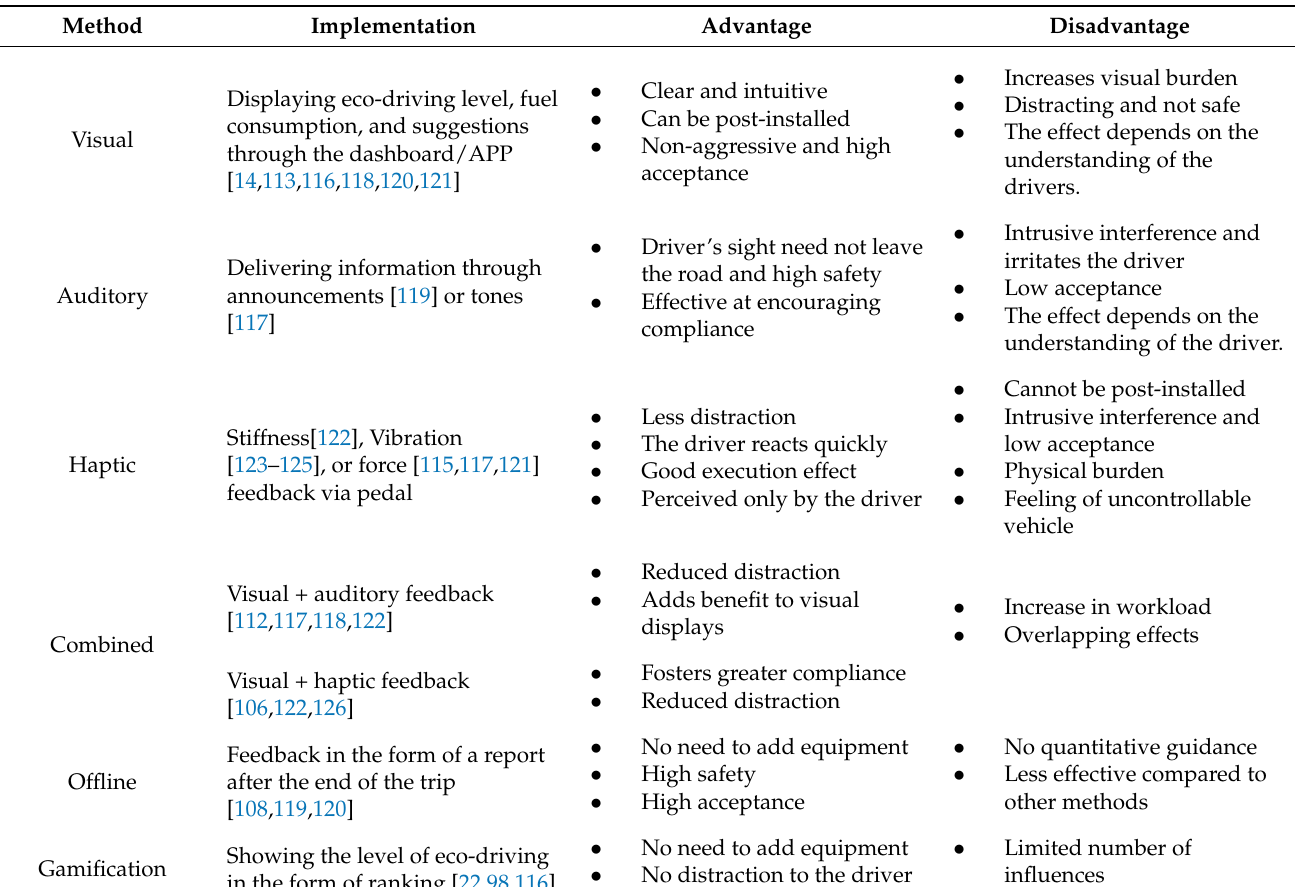
Table 3. The comparison of the main methods of feedback for